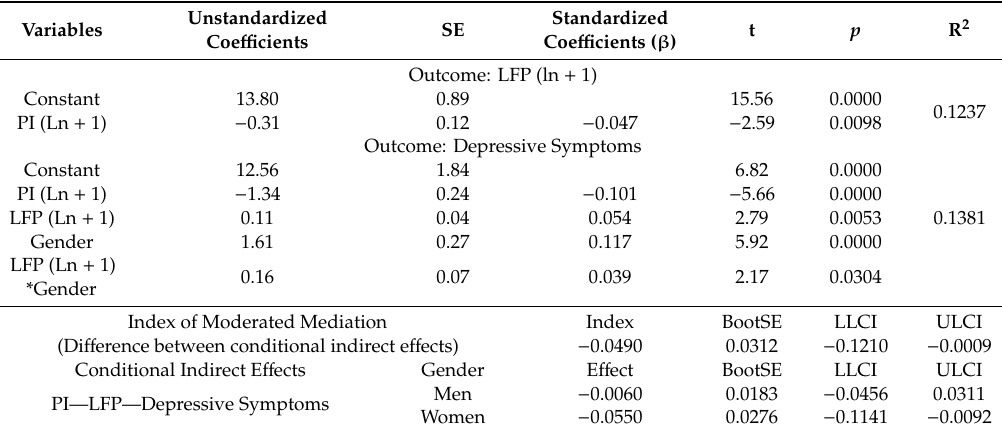
Table 3. The results of moderated mediation estimates.